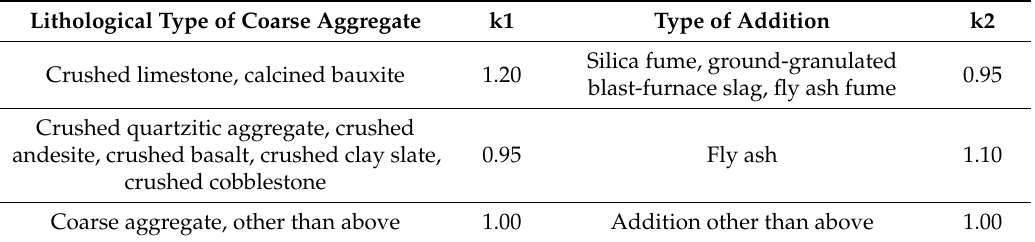
Table 13. Practical values of correction factor k1 and k2 .